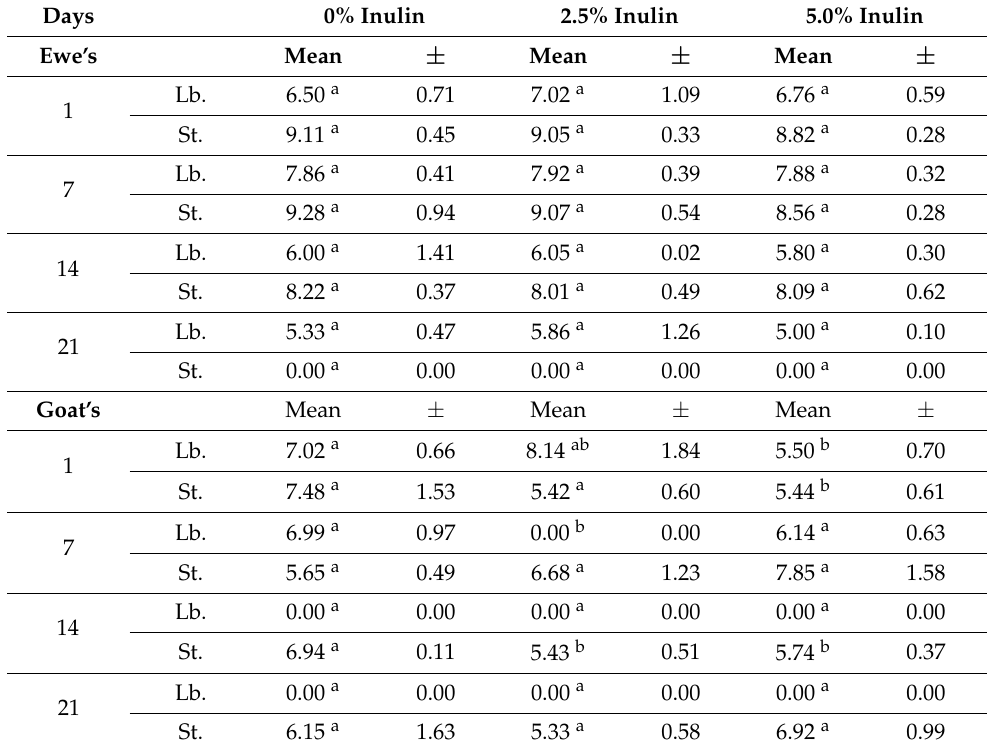
Table 7. Microbial counts (log CFU g − 1 ) of ewe’s and goat’s frozen yoghurt over storage. Lb. = lacto- bacilli; St. = streptococci (mean values and standard deviation).